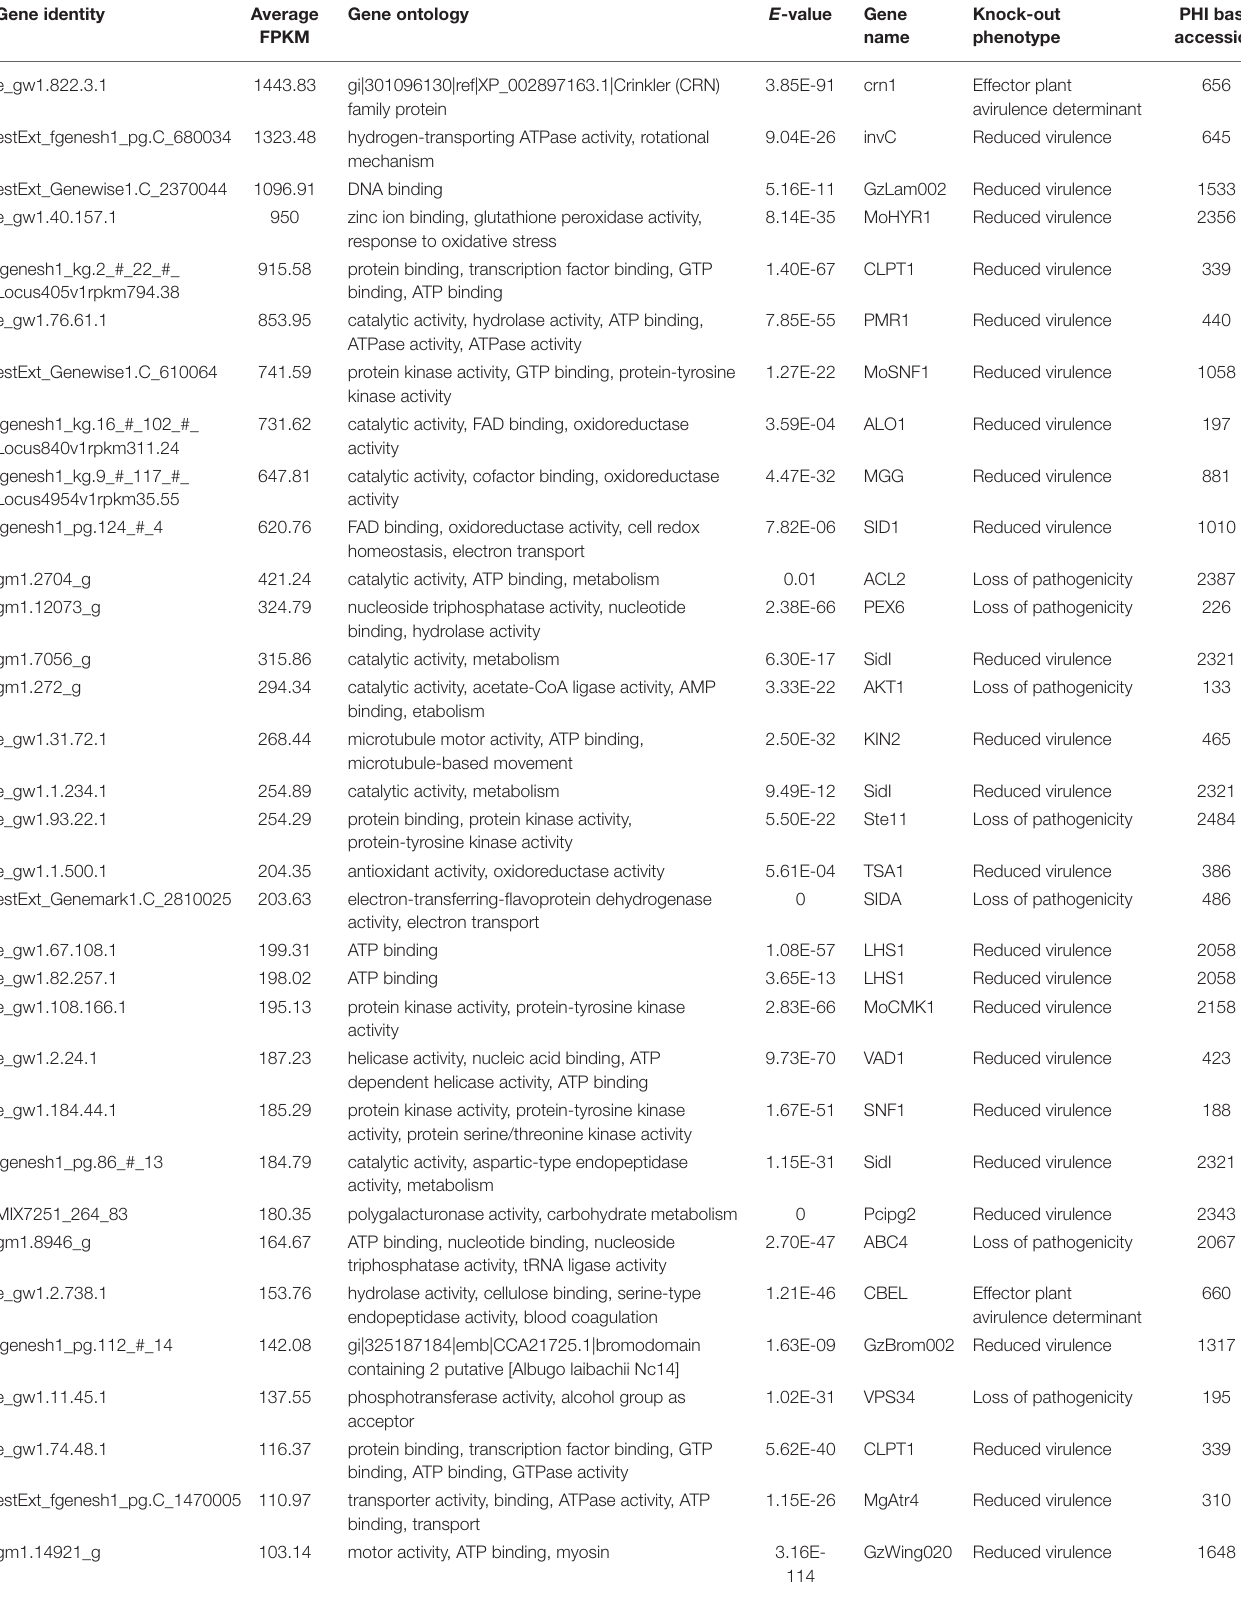
TABLE 3 | Phytophthora cinnamomi genes expressed in planta implicated in pathogenicity or virulence ( E -value < 0.01) based on comparison to the plant-host interactions